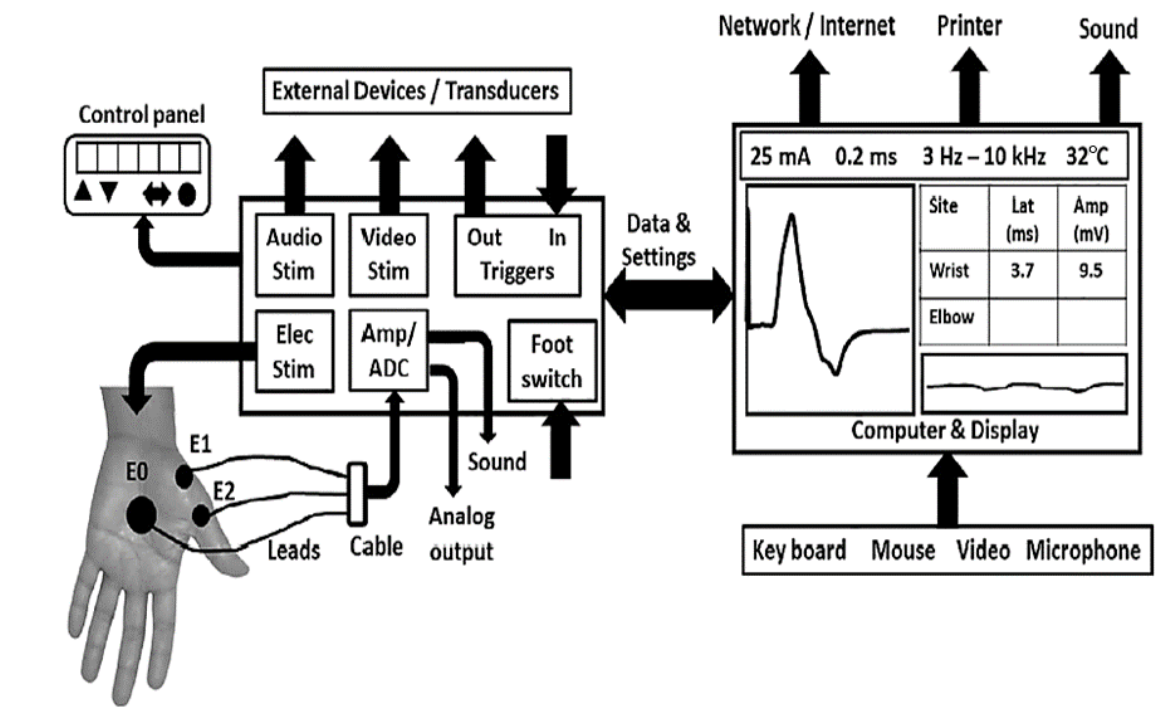
Figure 1. Schematic of generalized biopotential measurement (main components) [87] (Reproduced with permission from [87], Elsevier, 2020).